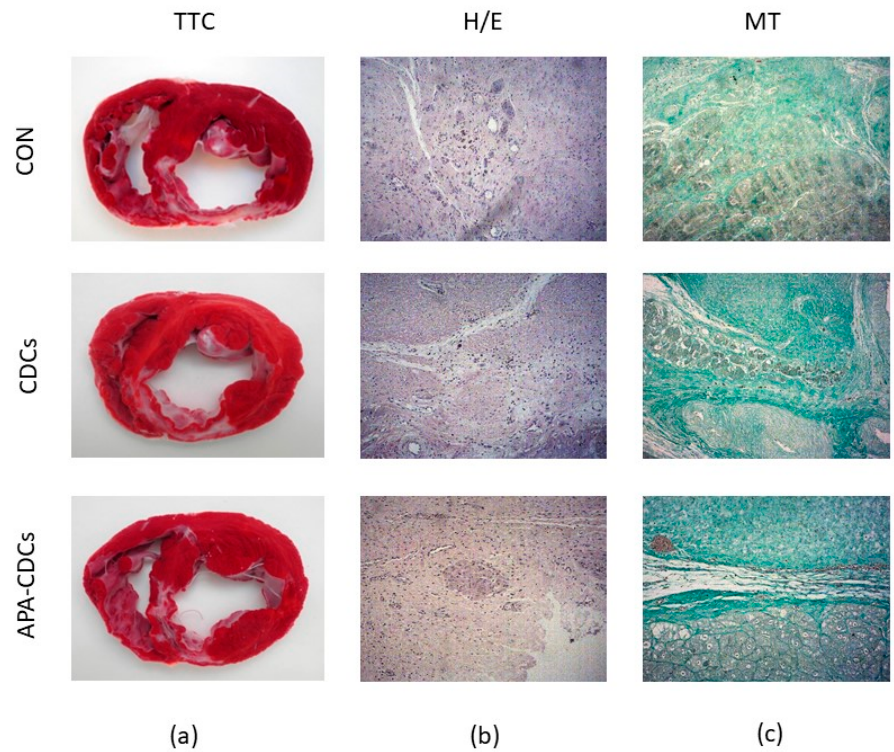
Figure 4. Macroscopical and histopathological appearance of the infarcts. ( a ) TTC staining showing the extension of infarcted tissue in the different groups. ( b ) Representative images from the three study groups of the infarct zone after H/E staining. ( c ) Representative images from the three study groups of the infarct zone after MT staining.